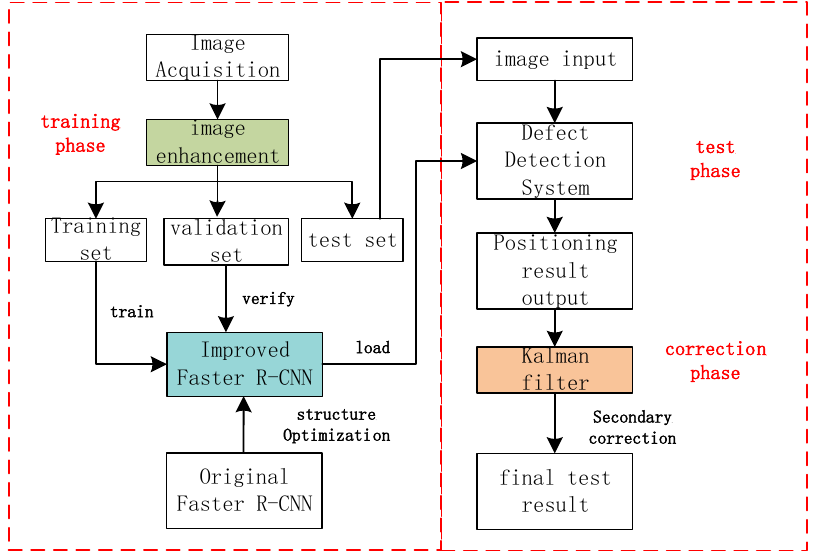
Figure 1. Overall framework of defect detection system for key components of transmission lines.